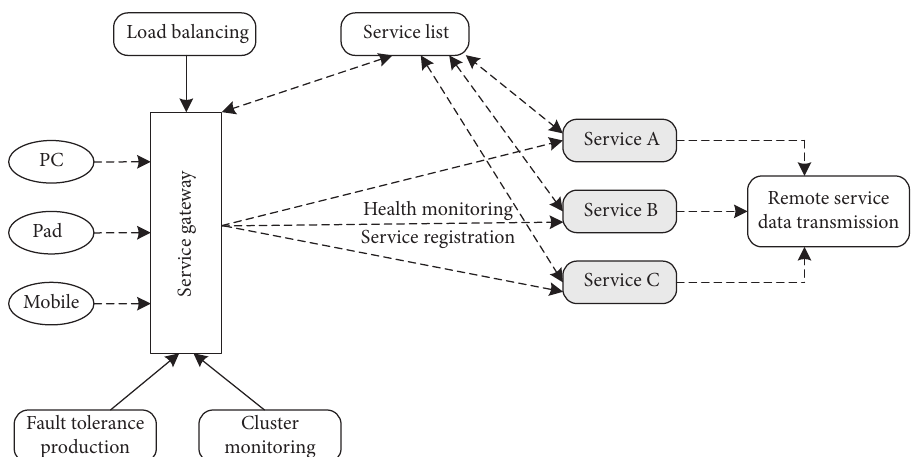
Figure 5: Concise request processing diagram of microservice